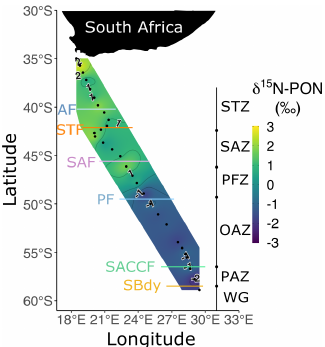
Figure 3. (a) Bulk chlorophyll a (chl a ) concentrations and (b) the proportion of chlorophyll a in the nano + size fraction at the surface for legs S and N. Abbreviations are as in Fig. 1. Figure produced using the package ggplot2 (Wickham, 2016).